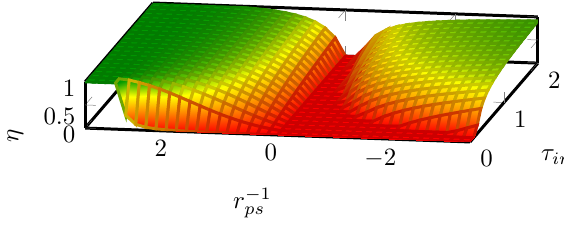
Figure 16. Efficiency for negative output velocities.